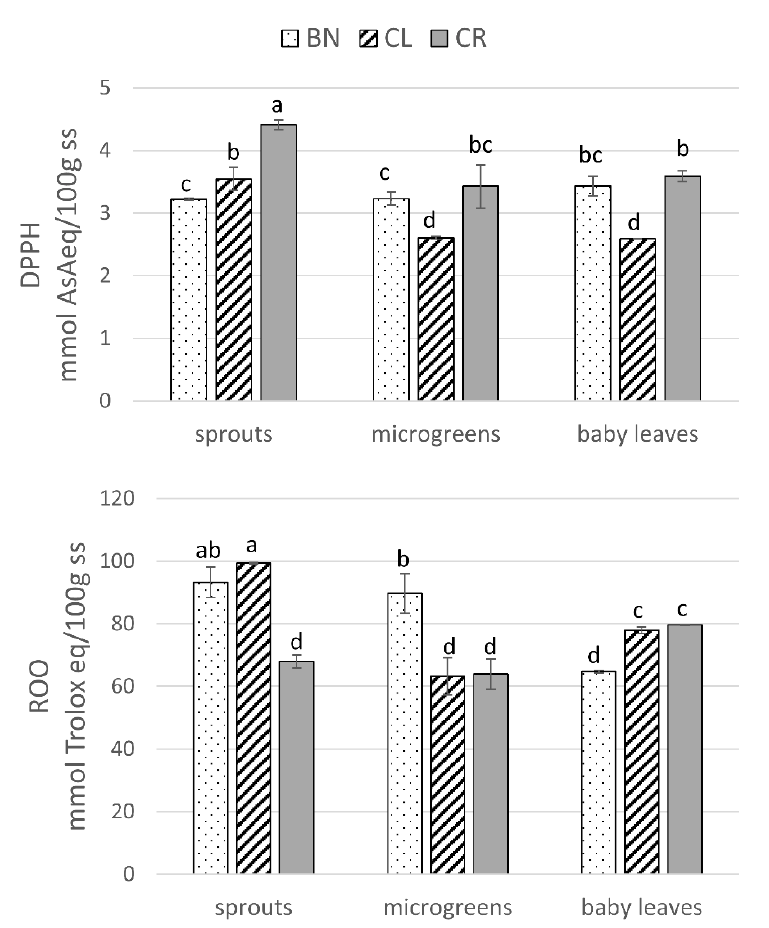
Figure 7. DPPH (mml AsAeq/100 g − 1 d.w.) and ROO (mmol trolox equ/100 g − 1 d.w.) in BN, CL and CR in sprouts, microgreens and baby leaves. Each value represents mean ± S.E. of three replicates. Bars with the same letters are not significantly different, as determined by Tukey’s test (p < 0.05).